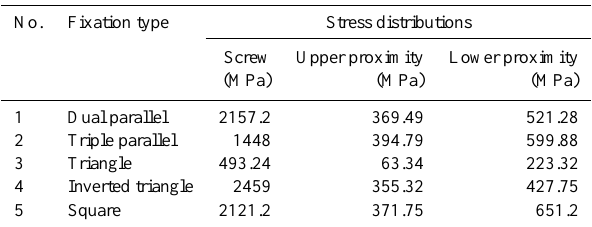
Table 2. The stress values in bone and